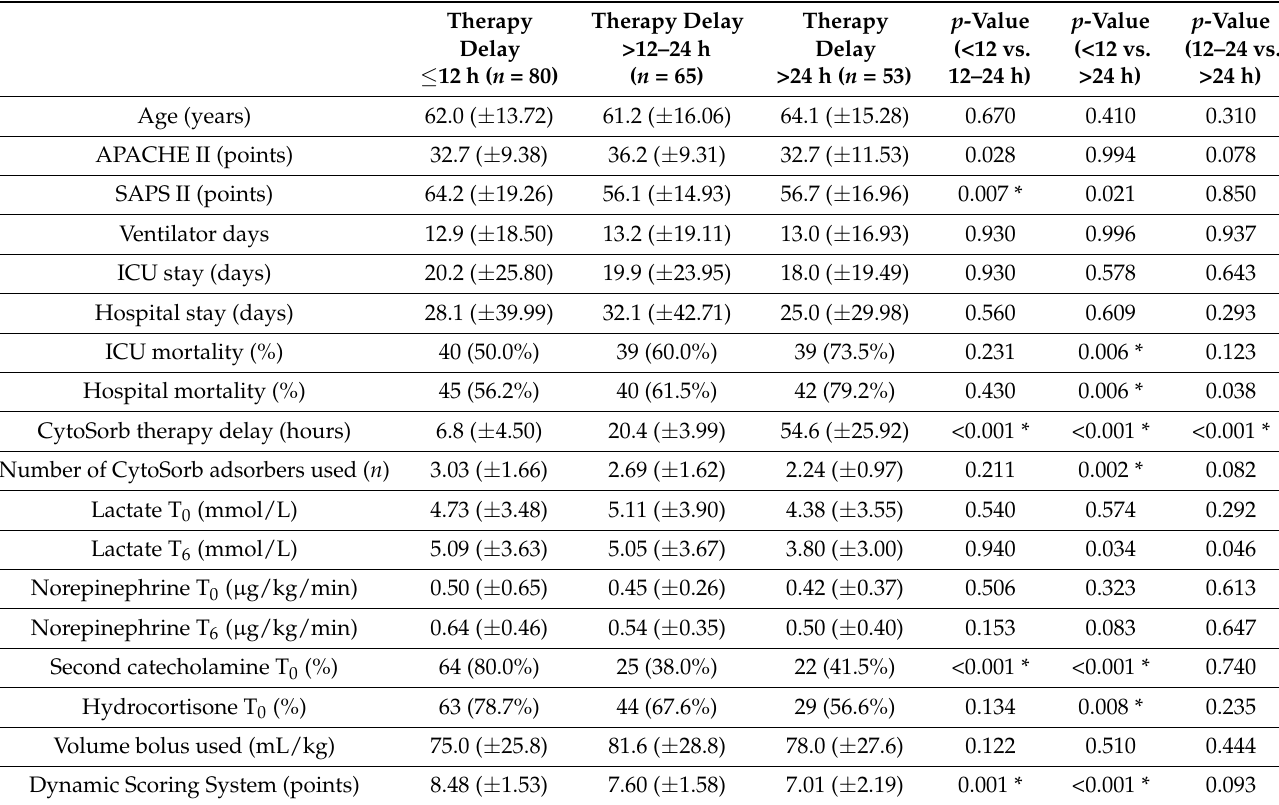
* = Statistically significant using Bonferroni-adjusted alpha critical value = 0.017.